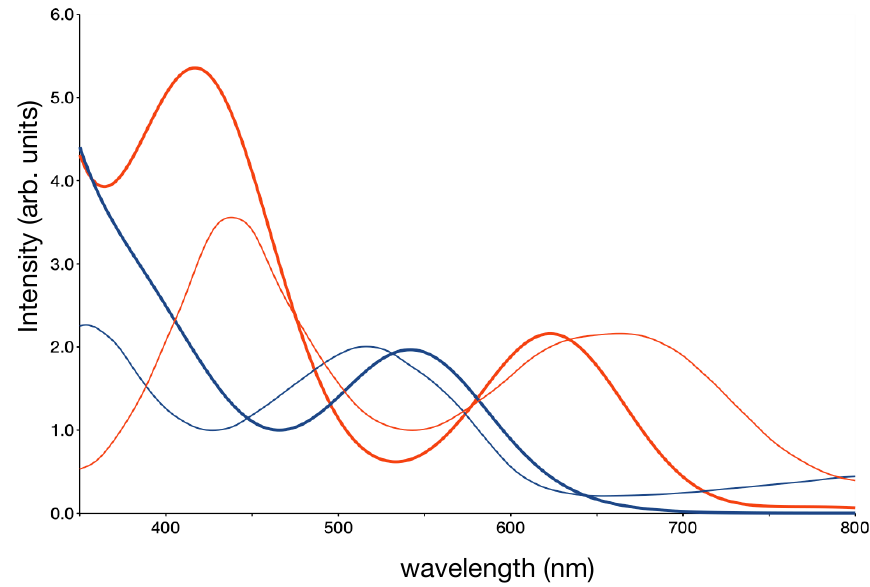
Figure 5. Calculated (thick lines) and experimental (thin lines) [29,30] UV–Visible spectra for [Fe(bpy) 2 (CN) 2 ] in methanol (blue) and [Fe(bpy)(CN) 4 ] 2 − in dimethyl sulfoxide